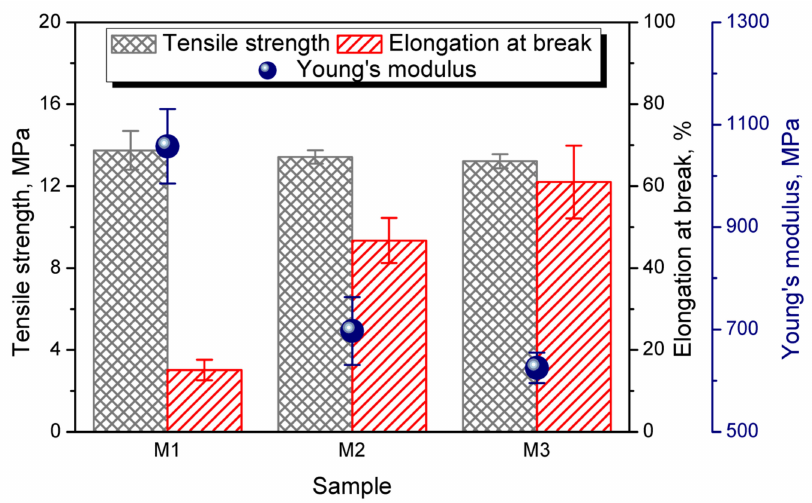
Figure 6. Tensile strength, elongation at break, and Young’s modulus of analyzed